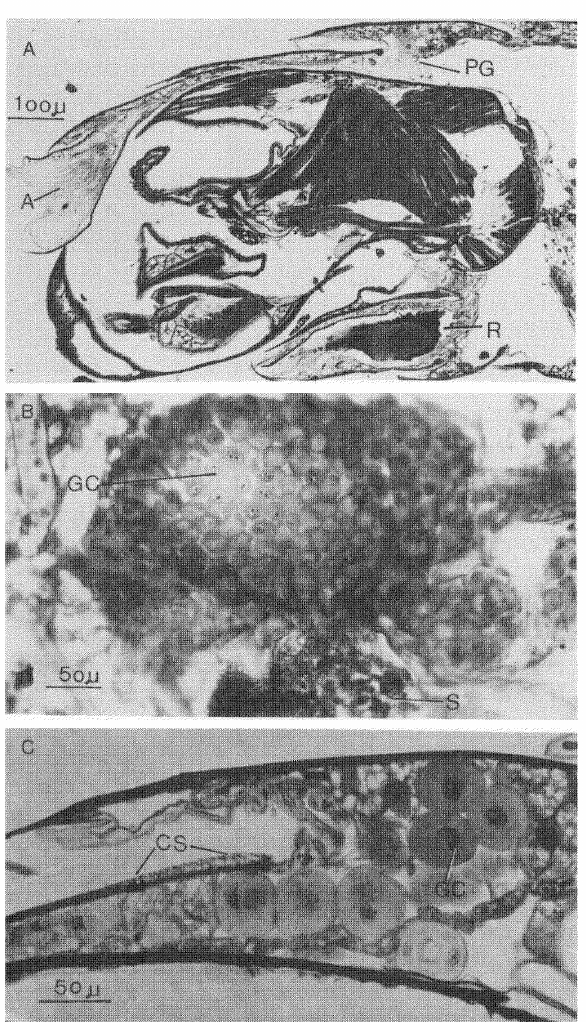
c, show- c. Note that the